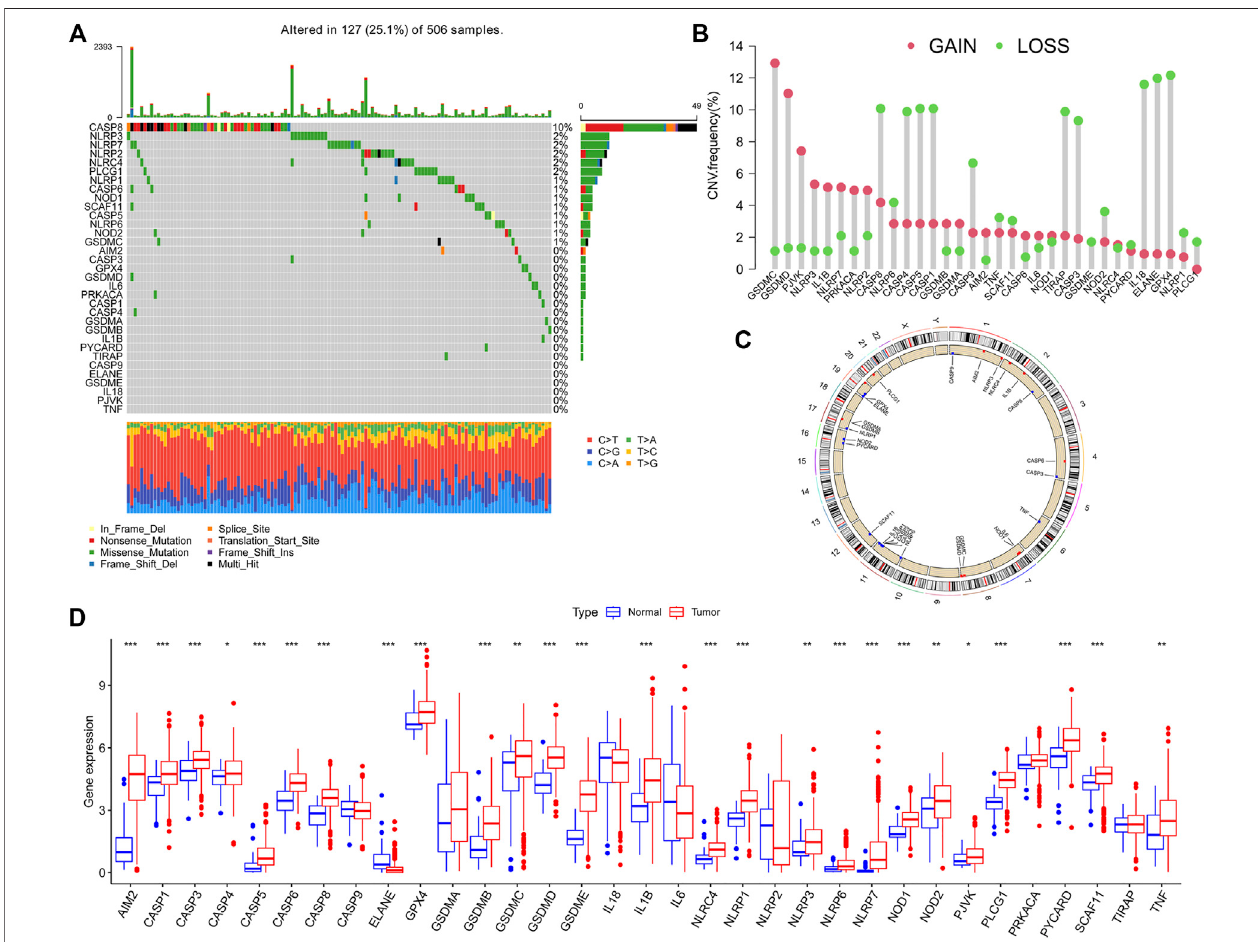
FIGURE 1 | Landscape of genetic and expression variations of pyroptosis-related genes (PRGs) in HNSCC patients. (A) . Summarized view of the occurrence of CNVandsomaticmutationsof33PRGsinTCGA-HNSCC. (B) .AnalysisoftheCNValterationfrequencydisplayedthatCNVchangeswerecommonin33PRGs,andthe frequency of the copy number gain and loss was similar. (C) . Location ofthe CNV alteration of these genes on chromosomes. (D) . Expression ofPRGsbetween normal and tumor in TCGA-HNSCC.